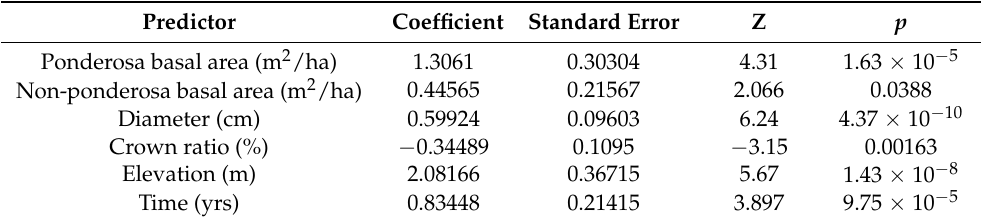
Table A2. Outputs from the Objective 1 model containing significant stand- and tree-level variables. Predictors have been mean-centered and scaled by their standard deviation.